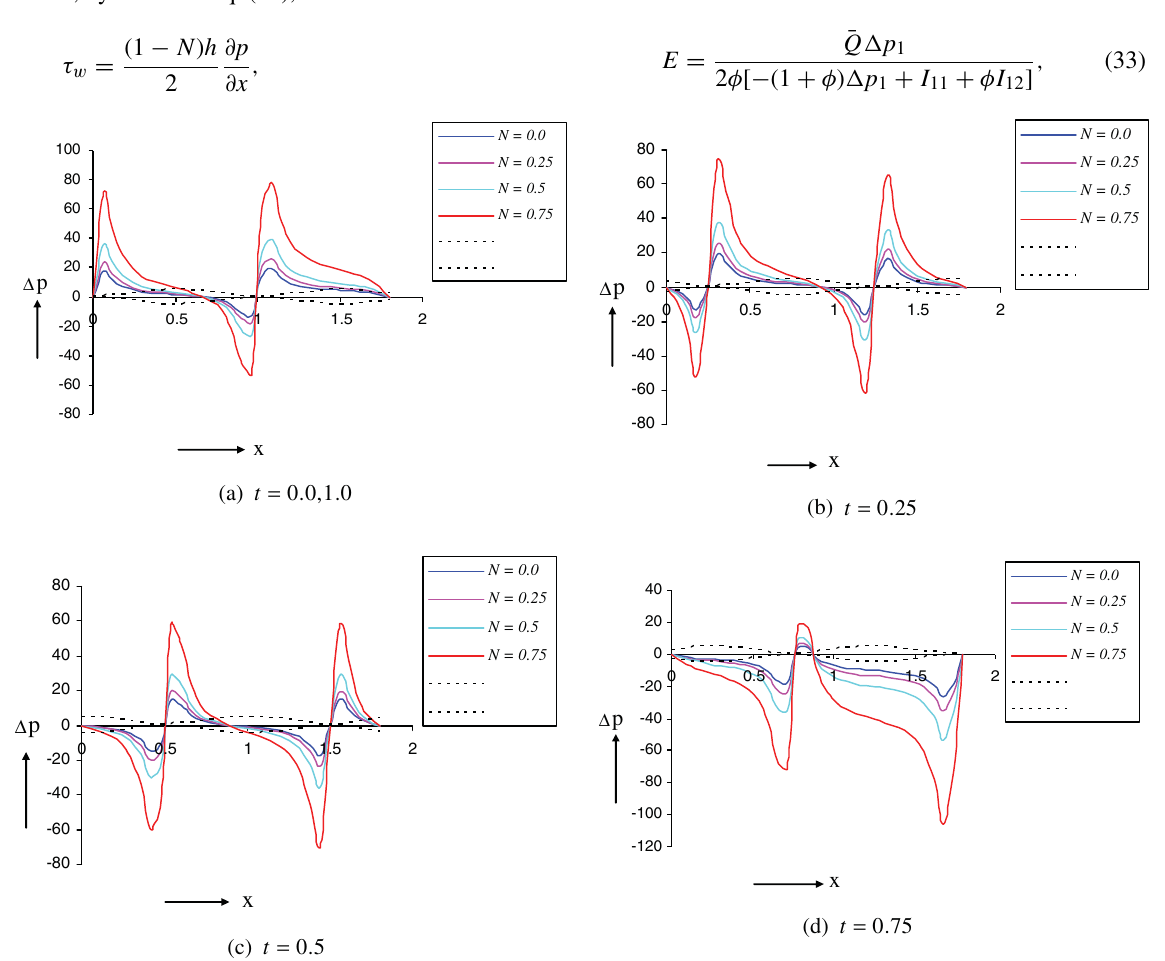
Fig.4. PressuredistributionalongtheaxialdistanceofthefinitelengthtubeatfivetimeinstantsbasedonEq.(23).Dottedlines( ······ )represent the position of wave, whereas continuous lines (—) represent the pressure distribution for N =0.0–1.0, φ =0.9, M =1.0 and l